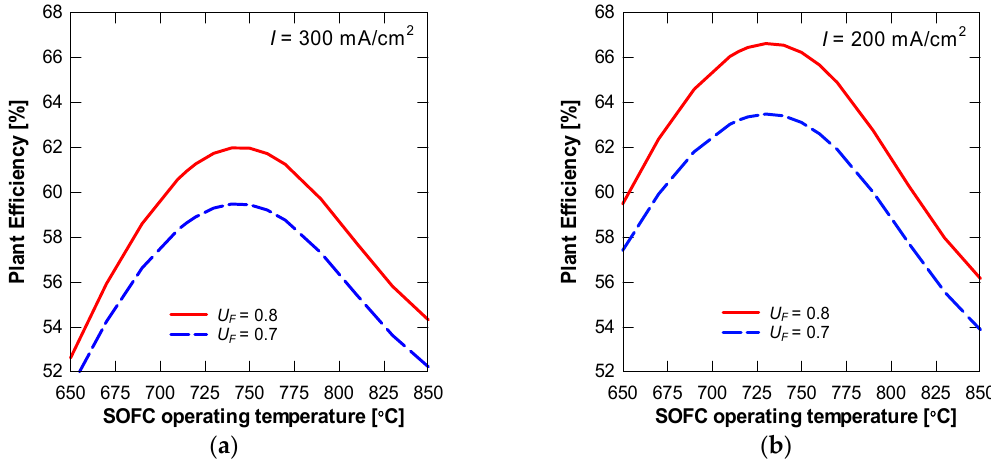
Figure 11. Effect of SOFC operating temperature on plant efficiency of repowering with SOFC, ( a ) For current density of 300 mA/cm 2 ; ( b ) For current density of 200 mA/cm 2 .